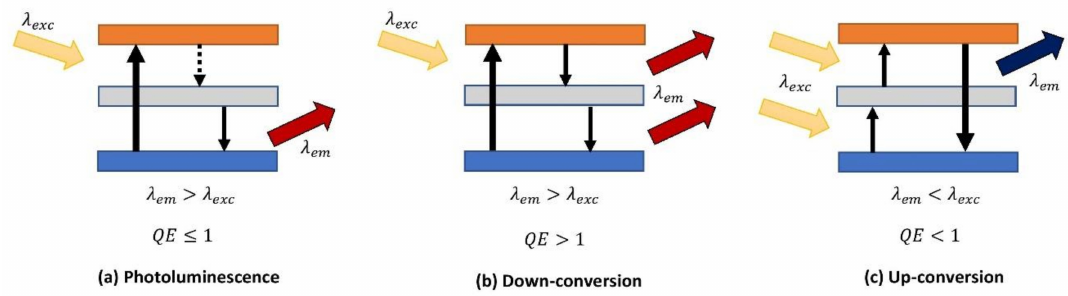
Figure 28. Schematic illustration of various spectral modification